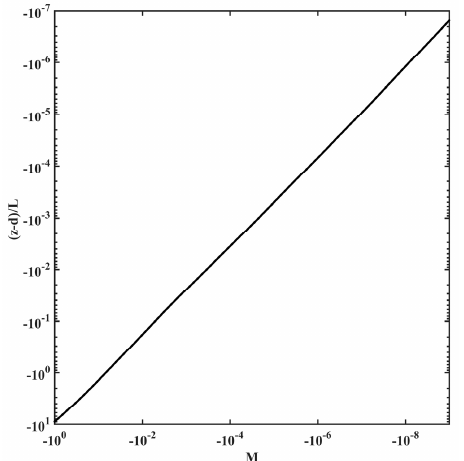
Figure 2. Solution of Equation (14) using fixed-point recursion, and the relationship of M and (cid:16) (cid:17) z ef f − d / L is monotonic.